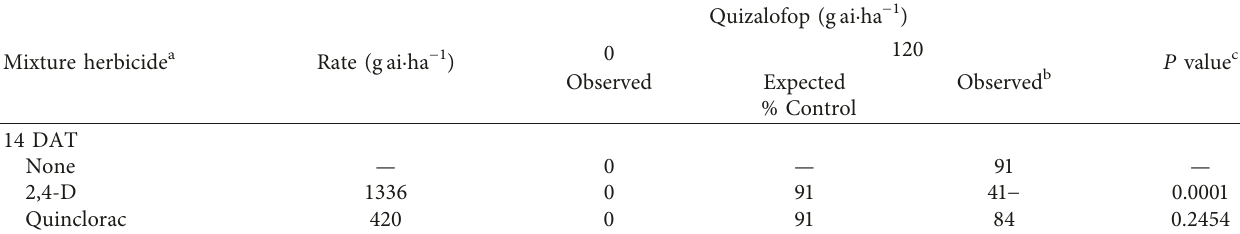
Table 4: Hybrid rice CLXL-745 IR control with quizalofop- p -ethyl mixed with different synthetic auxin or ACCase-inhibiting herbicides in 2015 and 2016 crop